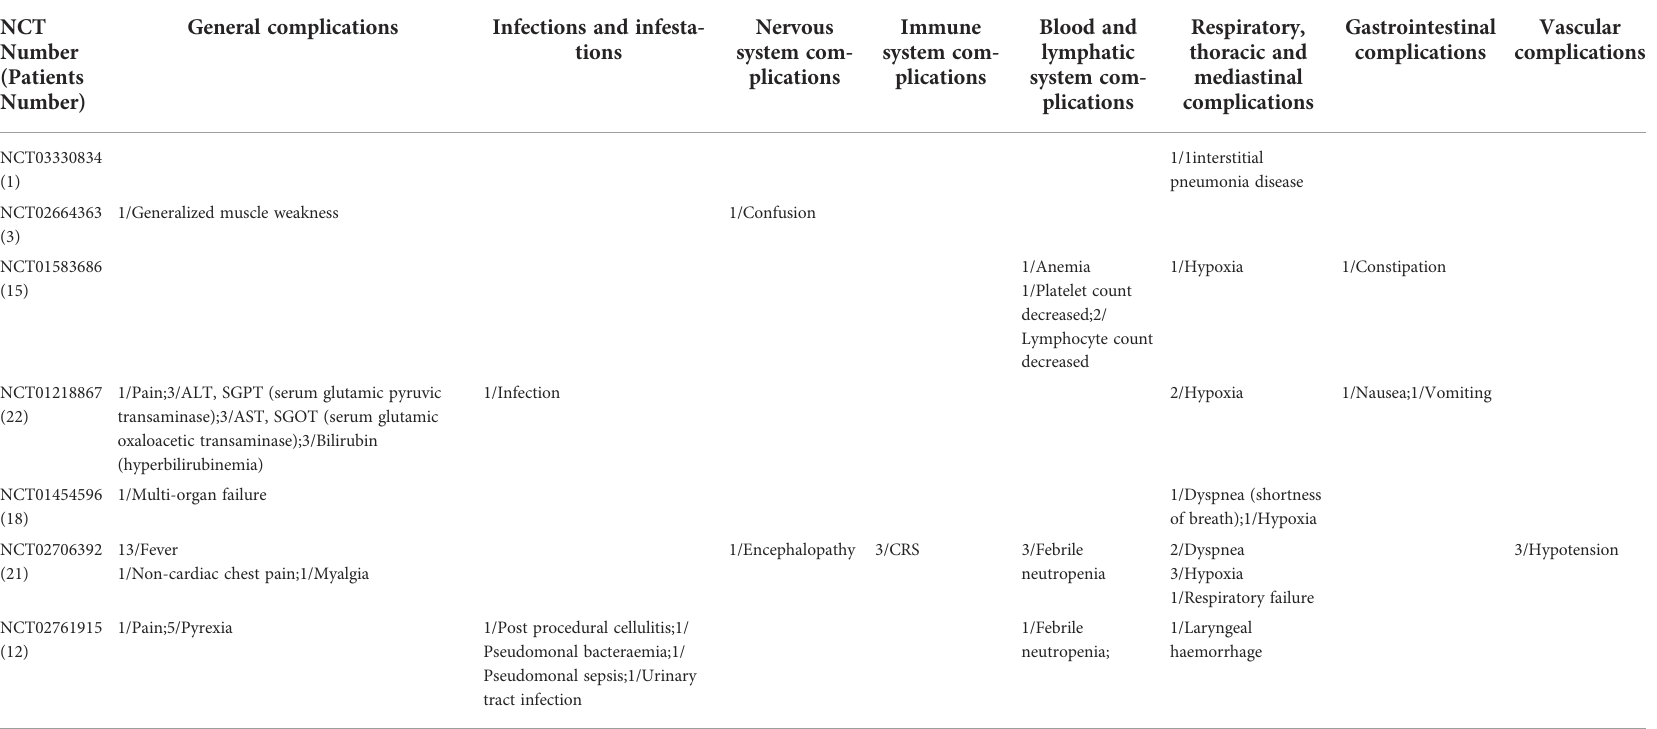
TABLE 4 Summary of clinical serious adverse events of CAR-T in solid tumors(Patients